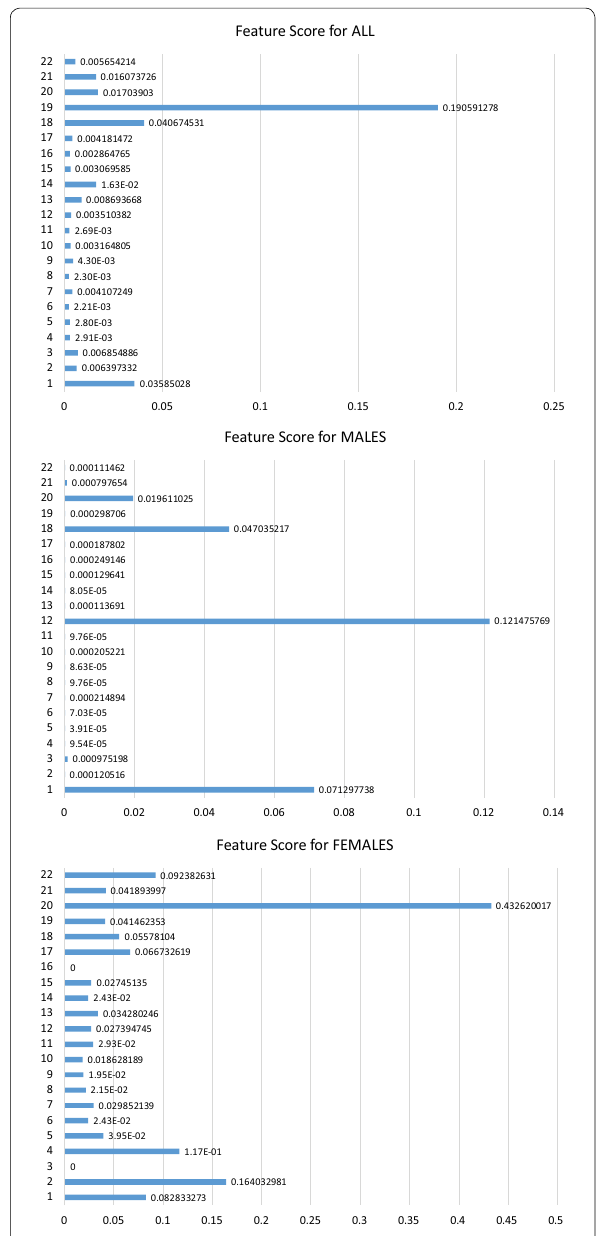
Fig. 3 Relative weights of all 22 features in detection of PD for both and only male and female